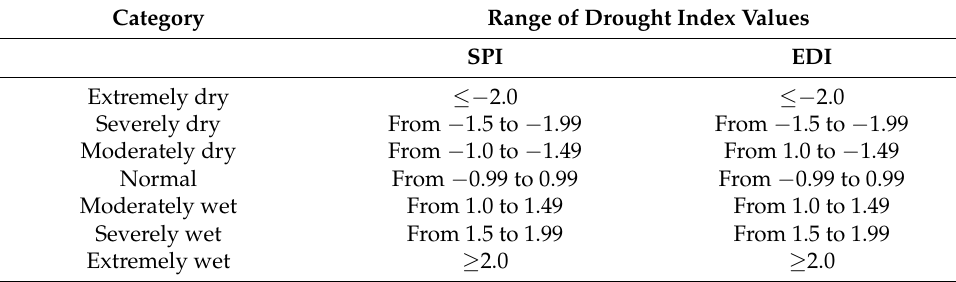
Table 1. Range of SPI and EDI values for drought